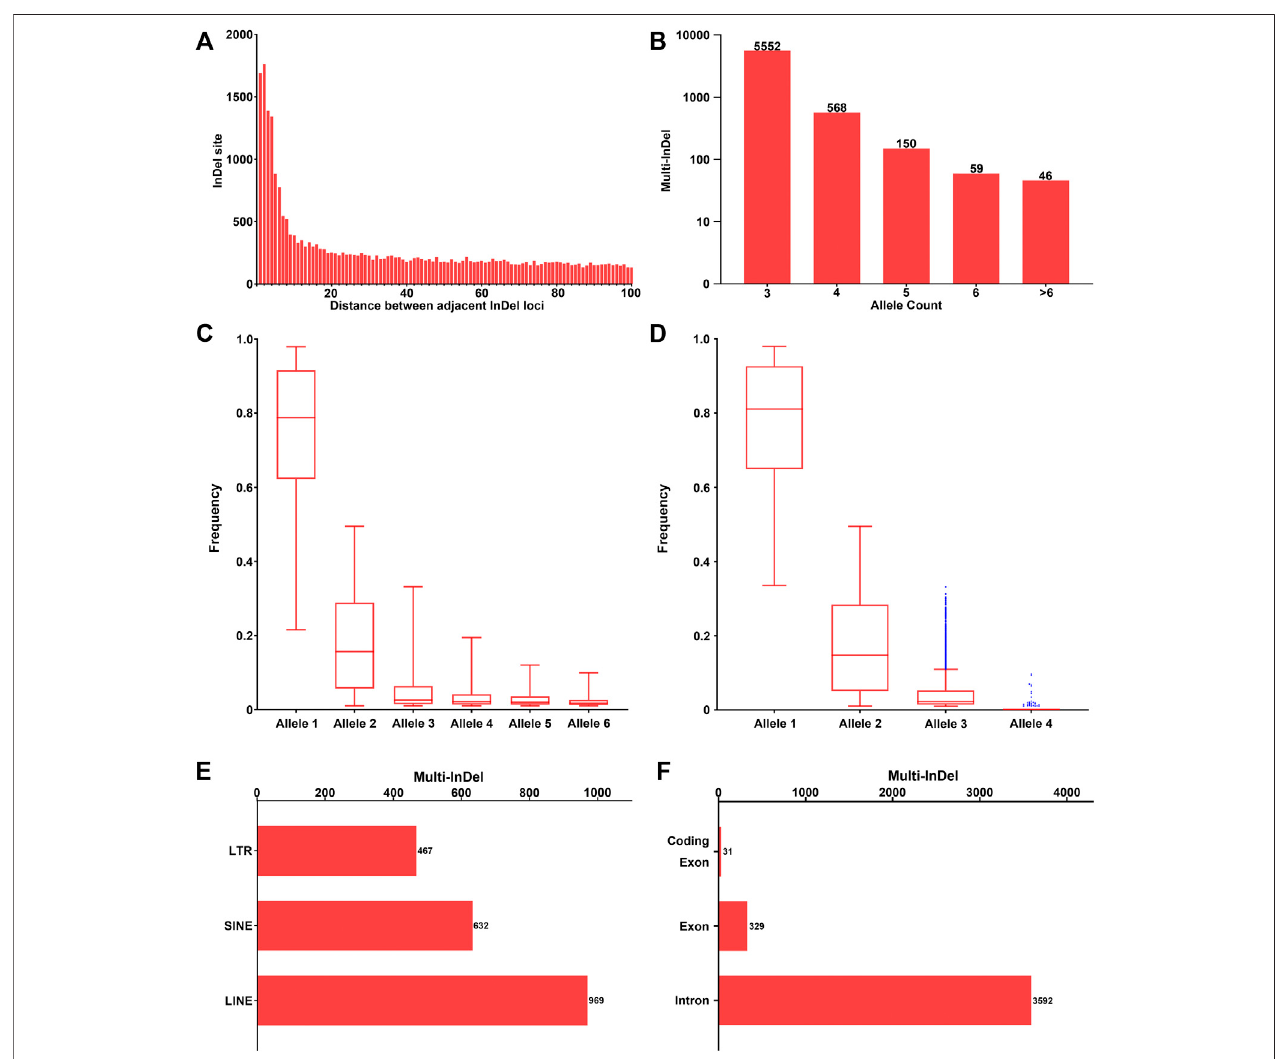
FIGURE 2 | Investigation of multi-InDels with random sequences across the genome. (A) The number of sets of two adjacent InDels with random sequences with theinterval1 – 100 bpisshown. (B) Numberofmulti-InDelswithrandomsequenceswithrelativeallelecounts.Alleleswithallelefrequency ≥ 0.01wereconsideredasvalid alleles. (C) Frequency distribution of multiple alleles at multi-InDels in worldwide populations. Alleles were sorted in a descending order by frequency in the global populationateachmulti-InDelmarker.Alleleswiththe6highestfrequencieswerereferredtoasalleles1 – 6. (D) Frequencydistributionofmultipleallelesatthemulti- InDels consisting of two InDels. Alleles were sorted in a descending order by frequency at each multi-InDel marker. The blue points represent outliers of the distribution based on Tukey ’ s method. (E) Genomic distribution of the multi-InDels with random sequences located in repeat elements. LTR , long terminal repeat; SINE , short interspersed element; LINE , long interspersed element. (F) Genomic distribution of the multi-InDels with random sequences located in annotated human genes.